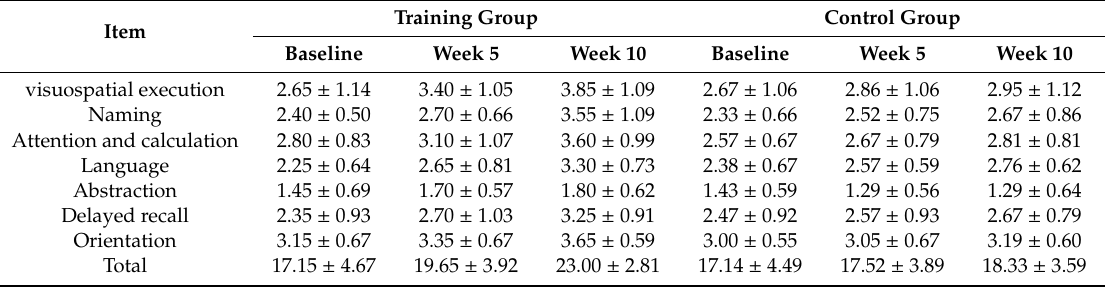
Table 10. MoCA scores at the di ff erent measurement times ( N = 41, and X ± SD).